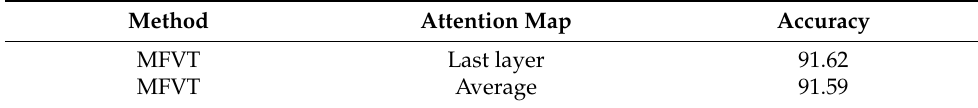
Table 5. Impact of different attention maps.